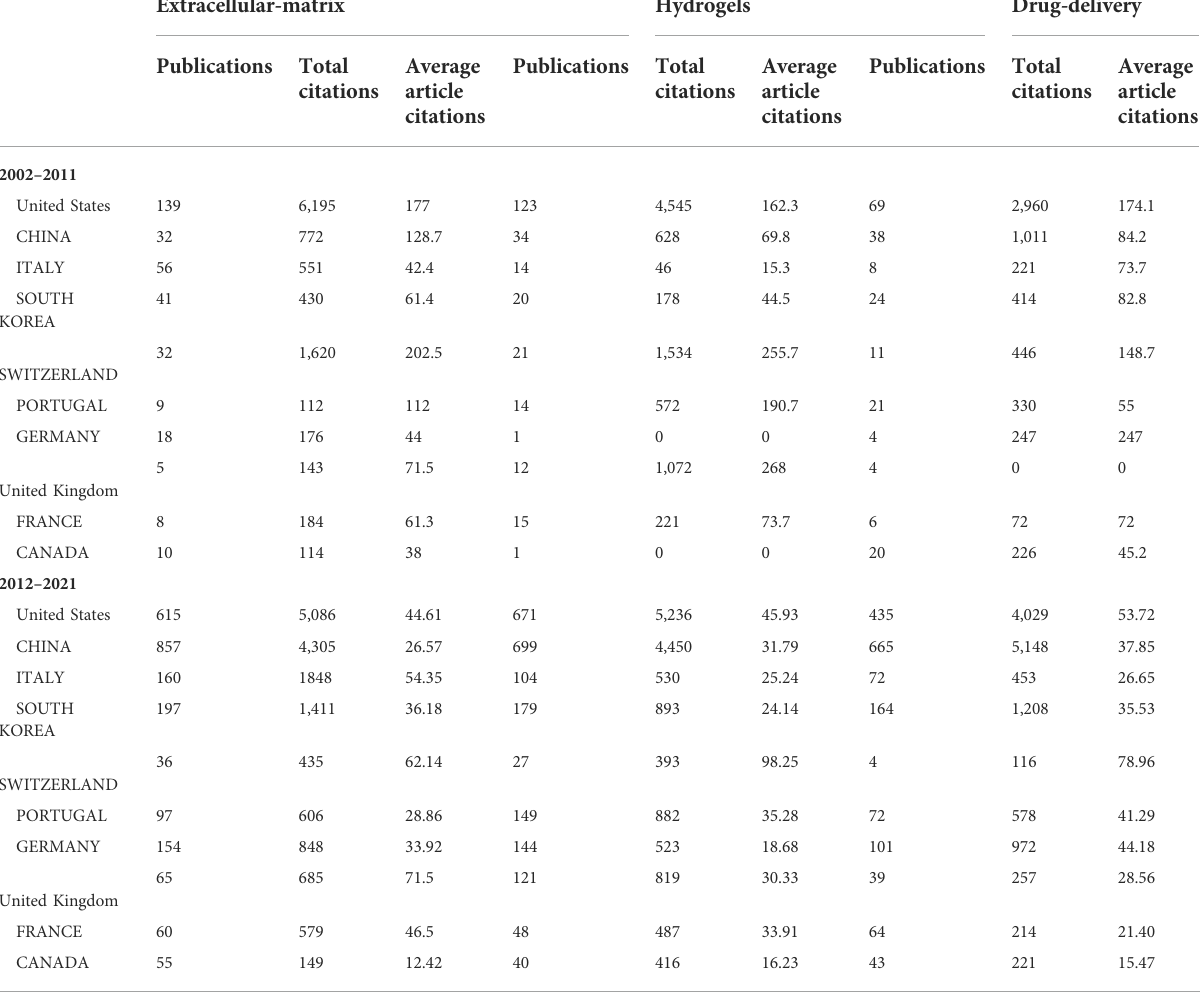
TABLE 3 Statistics of publication country related to bone regenerative materials between 2002-2021.